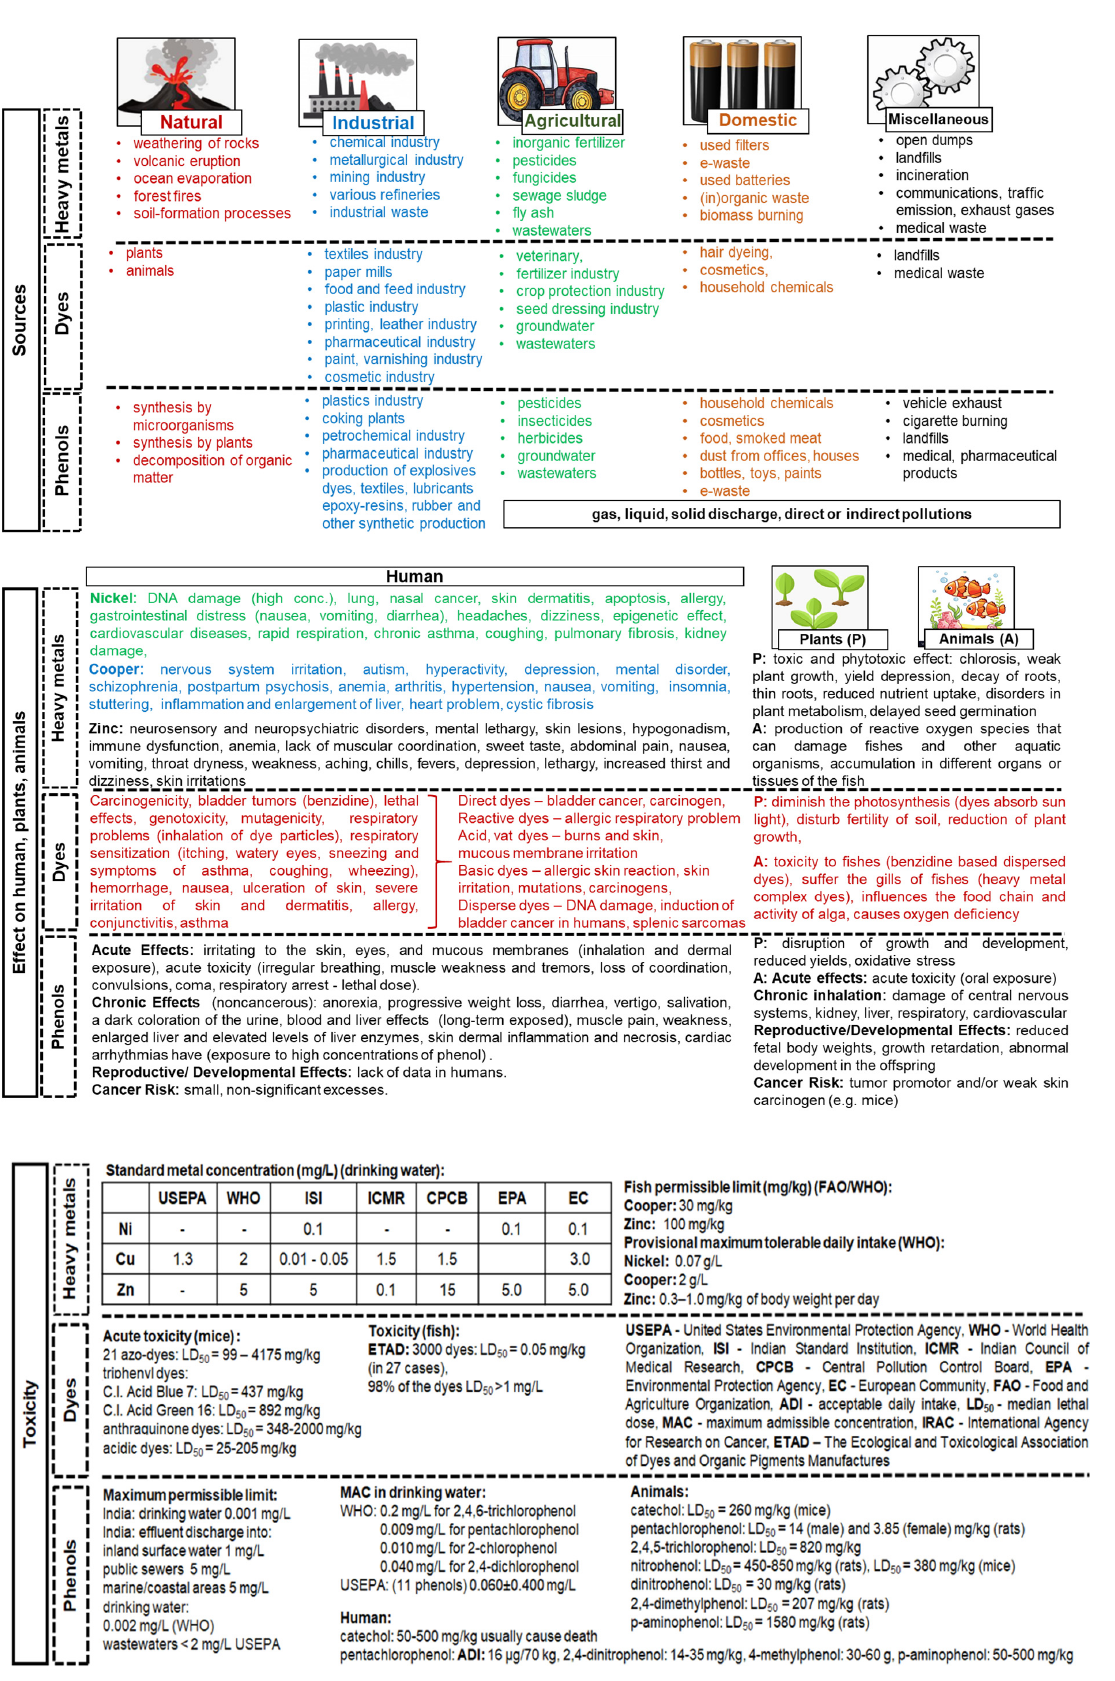
Figure 1. Sources of heavy metals, dyes and phenols in the environment and their impact on human, plants and animals and toxicity